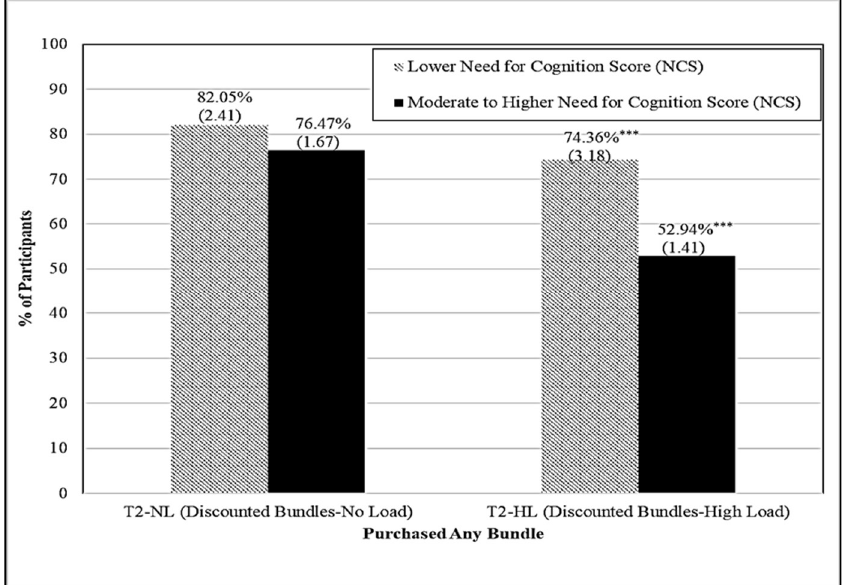
Figure 3. Bundle Selection by Treatment (when Discount Bundles were Displayed) and Need for Cognition Score (NCS). NOTE: Standard errors in parentheses. Differences within treatments between need for cognition scores (NCS) are significant at the 1% *** level if noted.